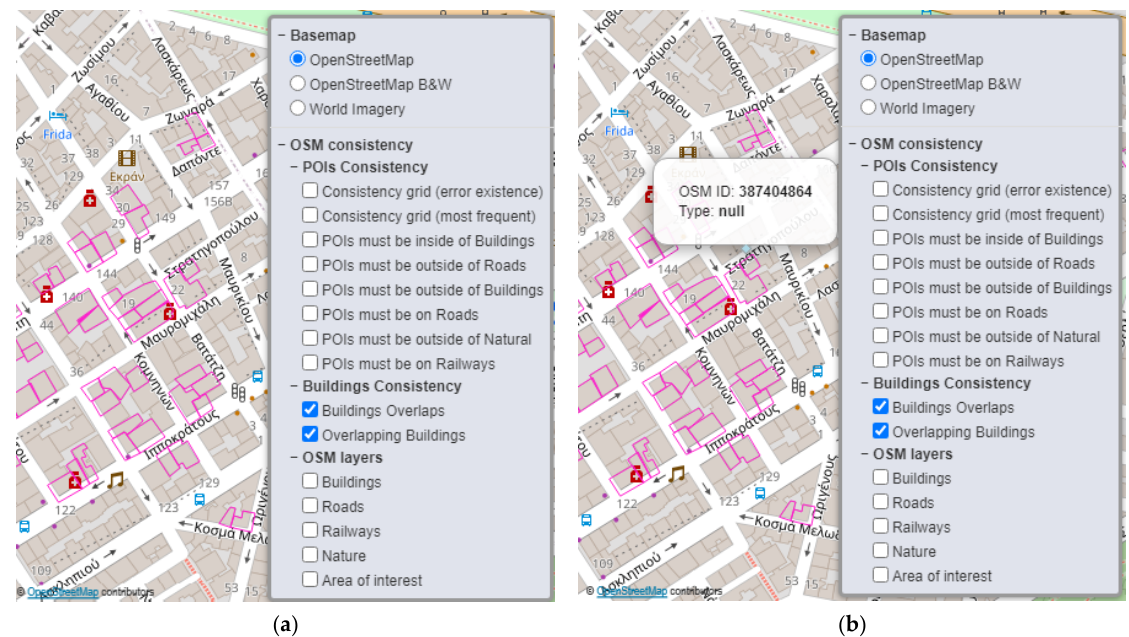
Figure 12. Consistency errors in buildings (Athens) are portrayed with ( a ) “Buildings Overlaps” and ( b ) “Overlapping Buildings” (Athens).